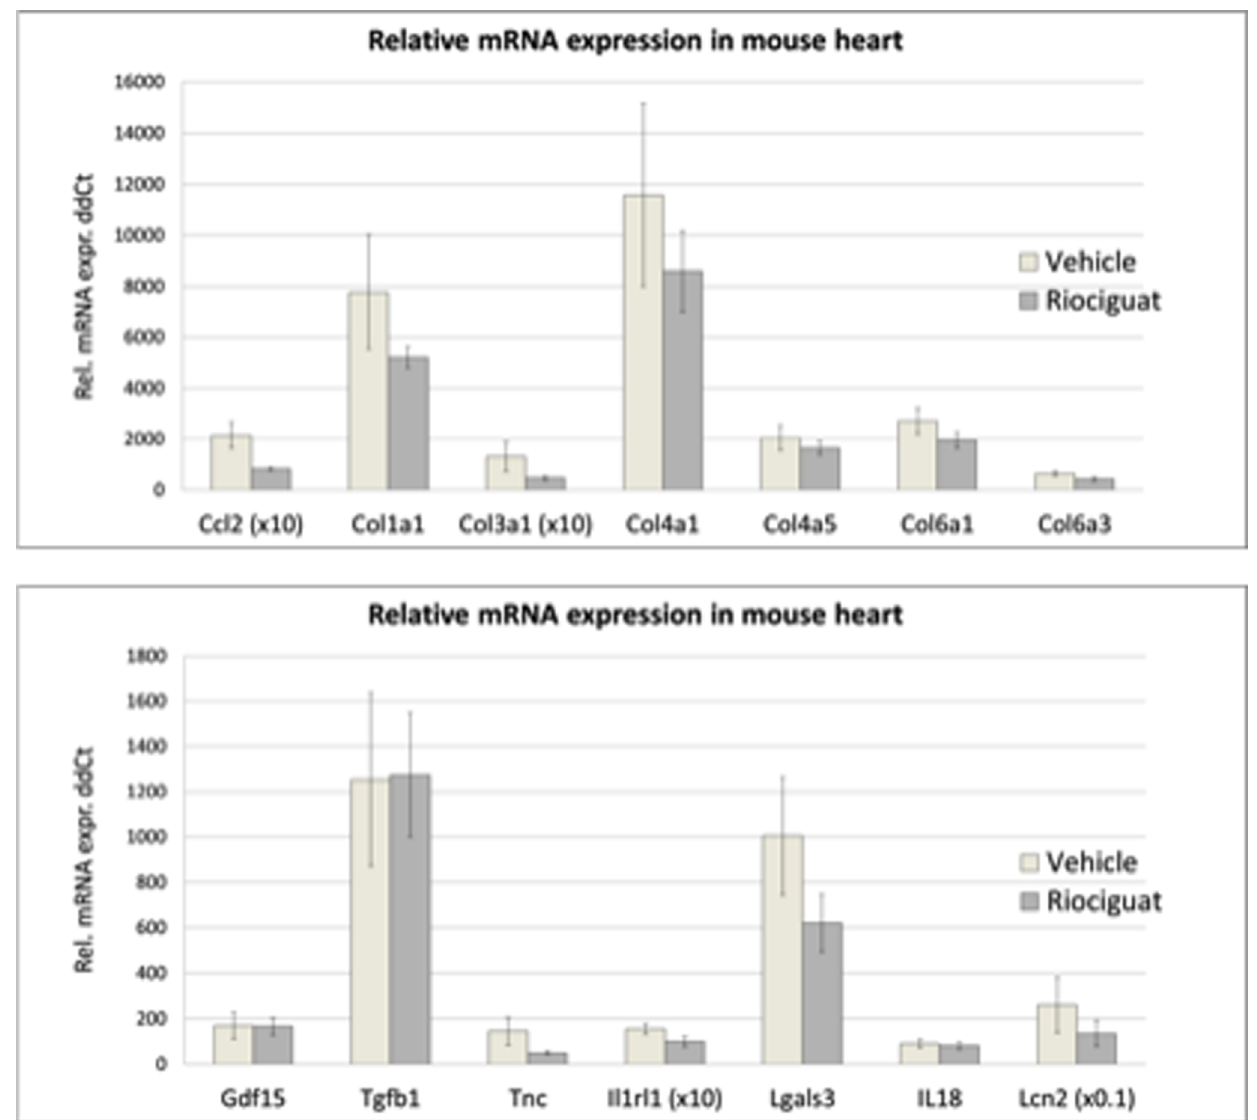
Figure 7. Relative mRNA expression in myocardium of vehicle or riociguat treated mice at day 28 post MI. Riociguat treatment resulted in a trend towards reduced levels of pro-fibrotic gene expression in MCP-1 (Ccl2), tenascin C, ST2 (Il1rl1), galectin-3 or lipocalin-2. Due to the high variation, significance was not reached for any of the genes tested gene. n=7.